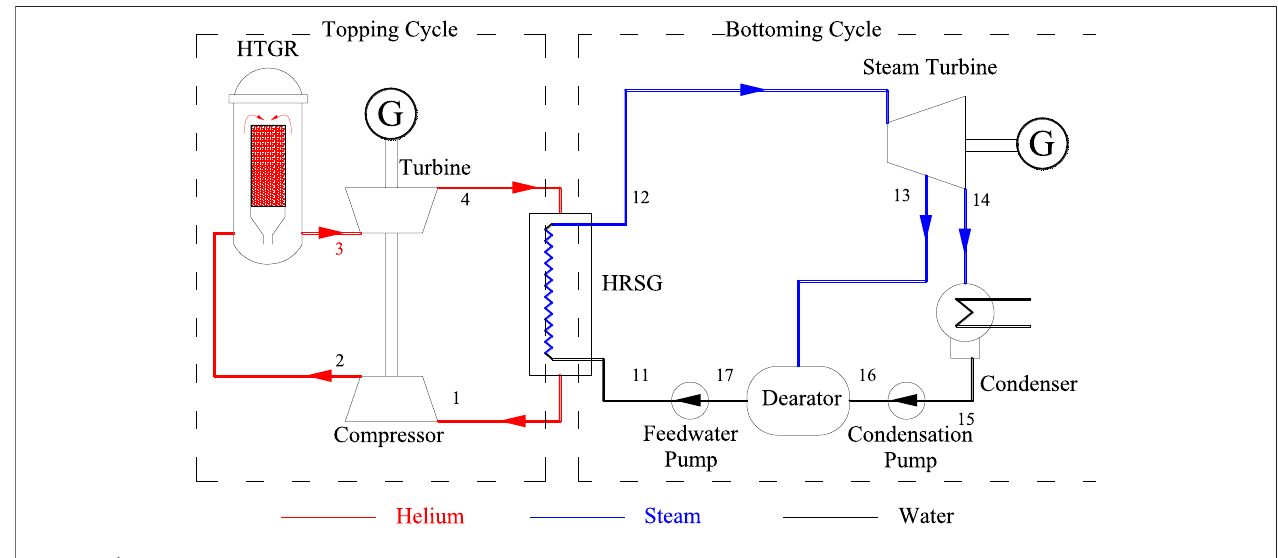
FIGURE 1 | Flow sheet of the